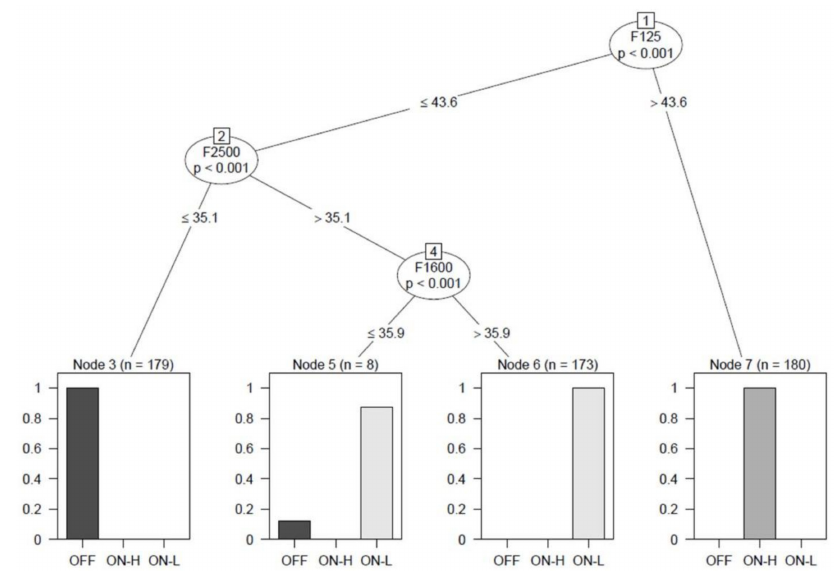
Figure 9. Conditional Inference Tree for the HVAC data. Each node tests a condition (test) on a particular property of the sound source (Frequency) and has two or more branches downwards.